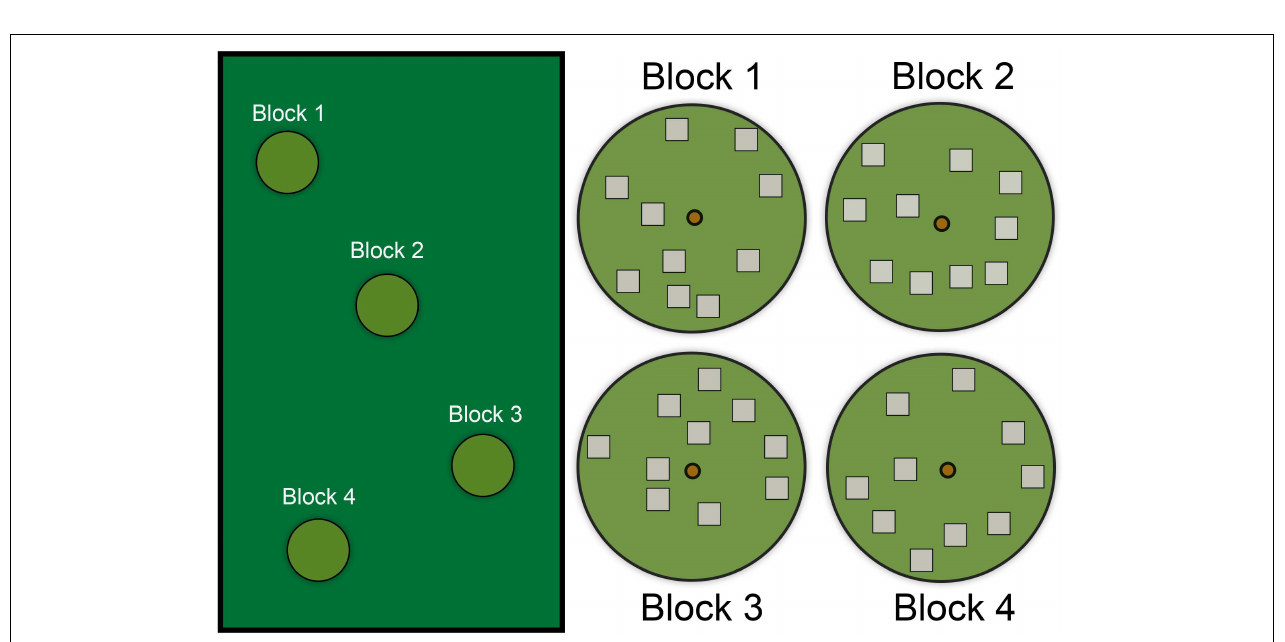
FIGURE 4 | Diagram showing four hypothetical random search “blocks” within a larger habitat. Each “block” contains ten randomly distributed 1 m 2 “plots.” The location of each block is selected within the larger habitat area based on the presence of a tree inhabited by anoles. The location of each plot is determined by random distance and direction (with or without constraints) from the center anchor (i.e., small circle in the center, which was a tree in our study). In this scenario, the circular block represents the limit of the radius from the anchor. Each plot is then searched thoroughly for anole eggs.